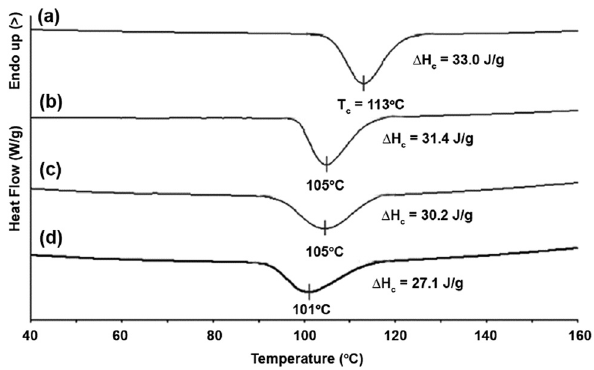
Figure 3: DSC cooling curves of PLLA - PEG - PLLA: ( a ) without CE and with CE contents of ( b ) 1.0, ( c ) 2.0, and ( d ) 4.0